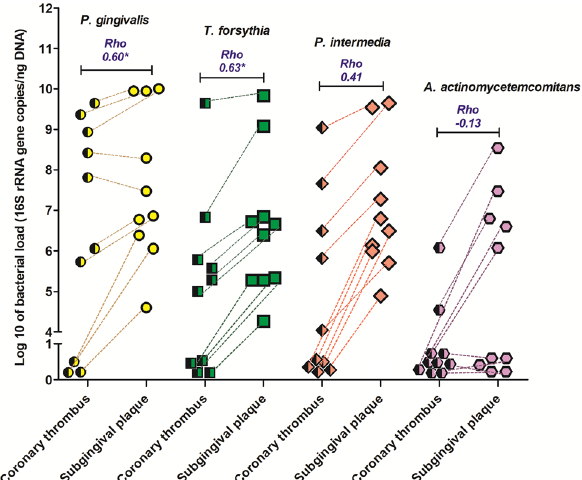
Figure 2. Comparison of within-subject periodontal pathobiont loads in intra-coronary thrombi and subgingival plaques collected from the myocardial infarction patients ( n = 10). Corresponding bacterial loads (16S rRNA gene copies/ng DNA) of four periodontal pathobionts: P. gingivalis (yellow), T. forsythia (green), P. intermedia (red) and A. actinomycetemcomitans (purple) in aspirated intra-coronary thrombi and subgingival plaque samples from ten ST-segment elevation myocardial infarction patients (dashed lines show paired samples for each patient). Rho-spearman’s correlation coefficient, * = p <